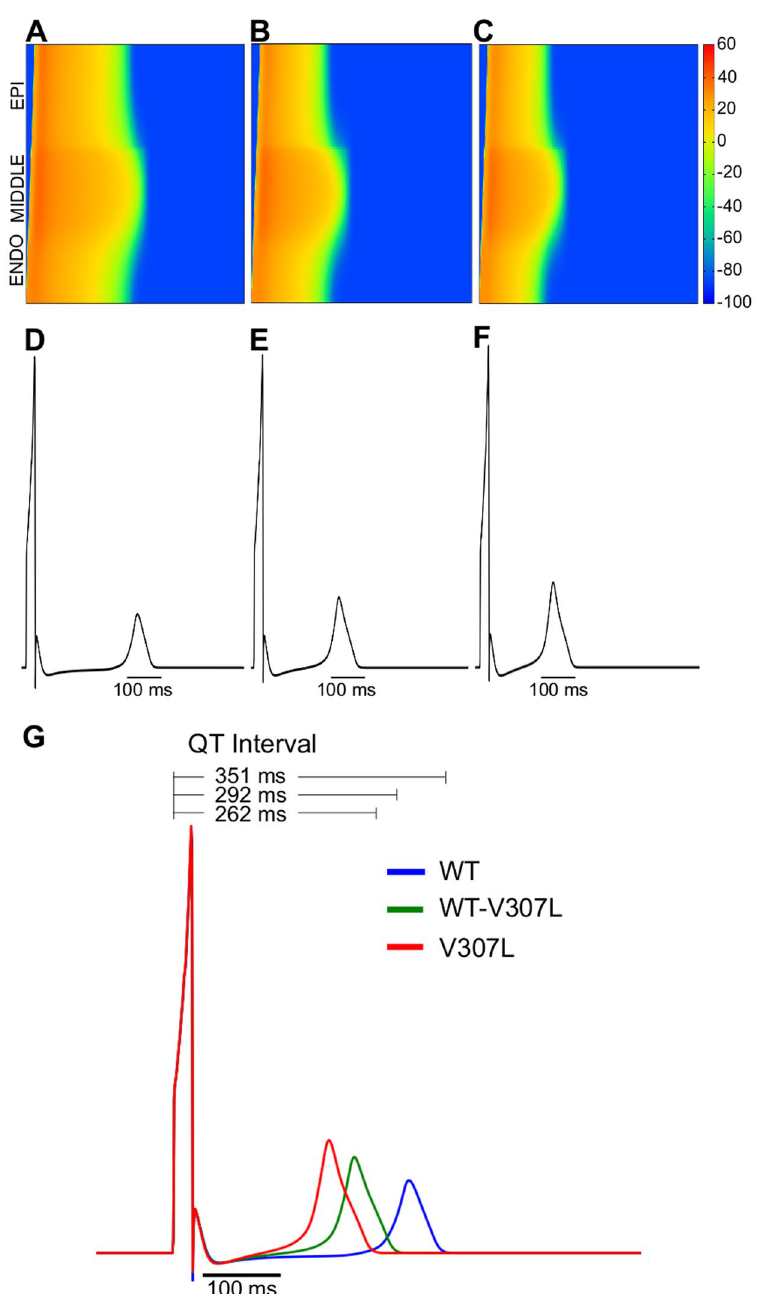
Figure 4. Pseudo-ECG measured in 1D strand. Space-time plot of AP propagation in a 1D transmural strand in WT ( A ), WT-V307L ( B ), and V307L ( C ) conditions, with membrane potential colour mapped from blue ( − 100 mV) to red ( + 60 mV). Space runs vertically from the endocardial (ENDO) end (bottom) to epicardial (EPI) end of the strand (top), and time runs horizontally. Pseudo-ECGs measured in WT ( D ), WT-V307L ( E ), and V307L ( F ) conditions. Superimposed pseudo-ECGs for the WT, WT-V307L, and V307L conditions, with associated QT intervals ( G